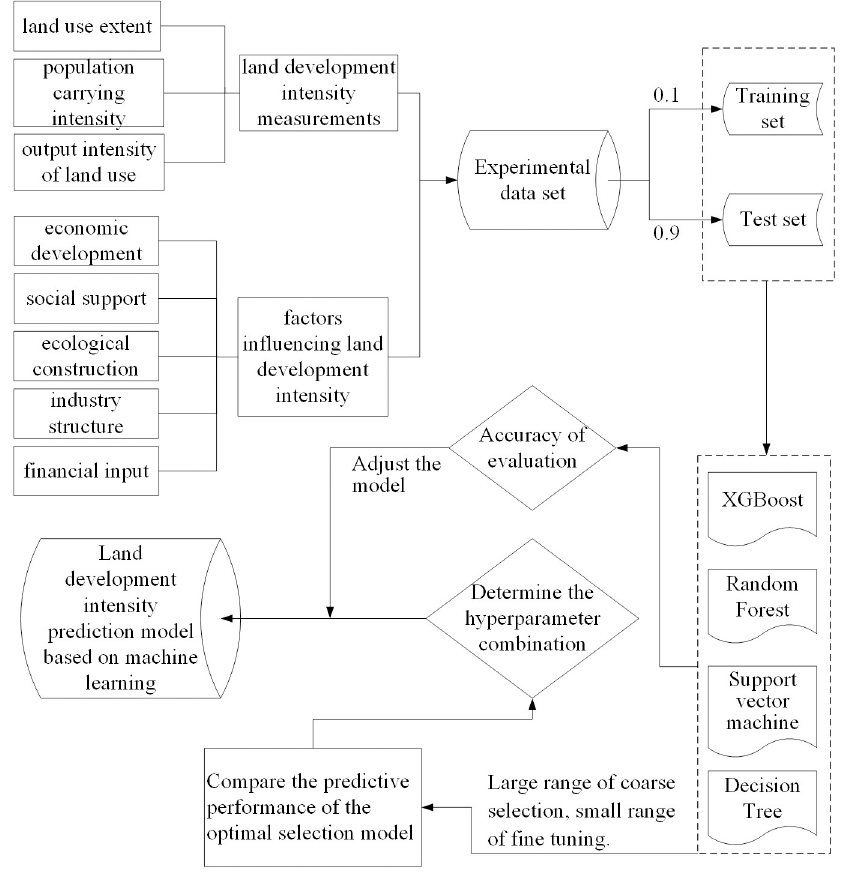
Fig 1. Research theoretical